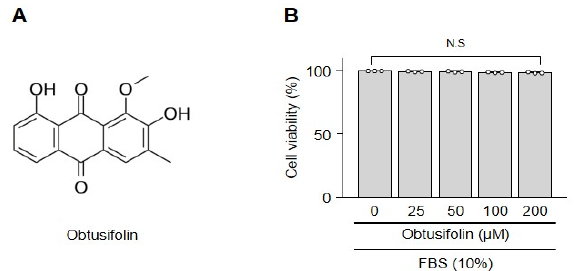
Figure 1. Viability of chondrocytes after obtusifolin treatment. The structure of obtusifolin ( A ). Chondrocytes were treated with obtusifolin for 24 h in a dose-dependent manner, and viability was measured using the lactate dehydrogenase assay ( B ). Data were analyzed using the one-way ANOVA, and values of each group ( n = 3) are shown as mean ± SEM; N.S, nonsig-